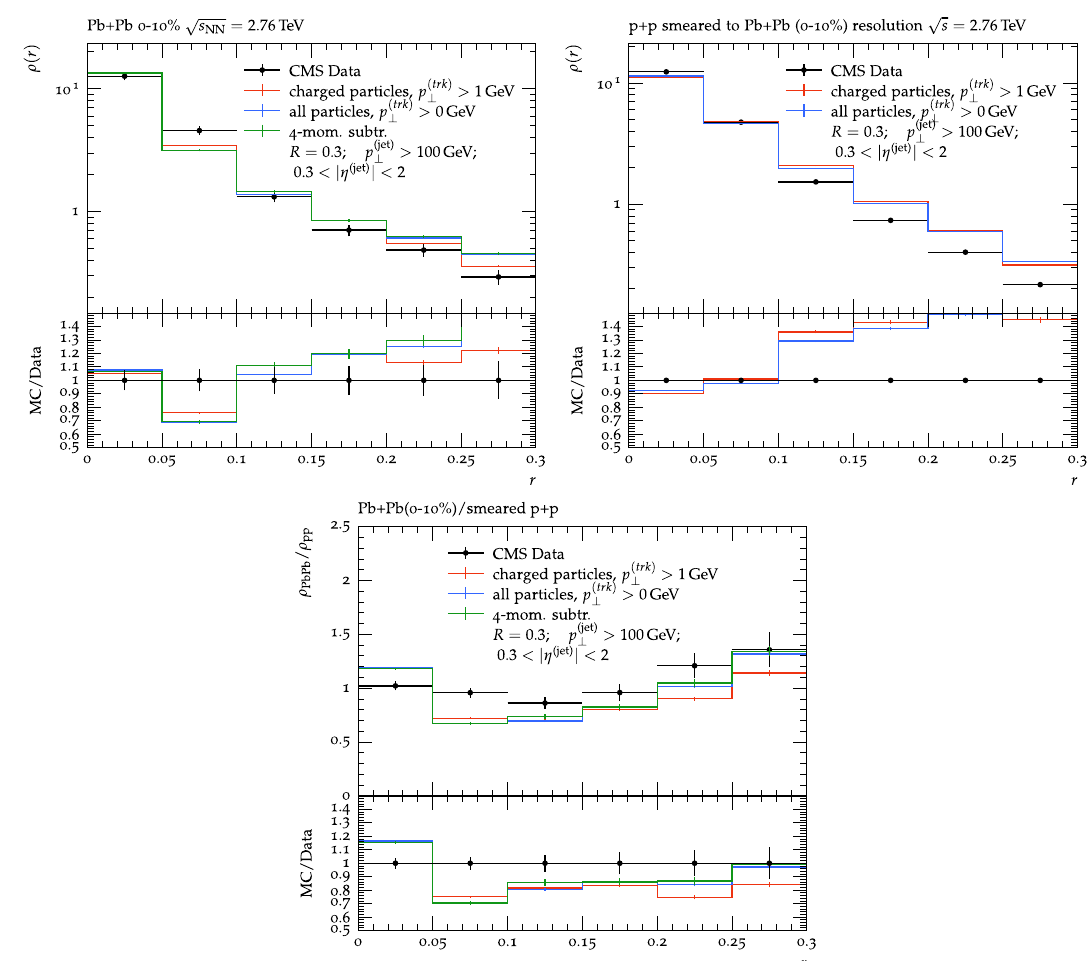
Fig. 7 Jet-hadron correlation function measured by CMS [79] at √ s NN = 2 . 76 TeV for R = 0 . 3 anti- k ⊥ jets with p 0 . 3 < | η ( jet ) | < 2. The correlation includes only charged particles with